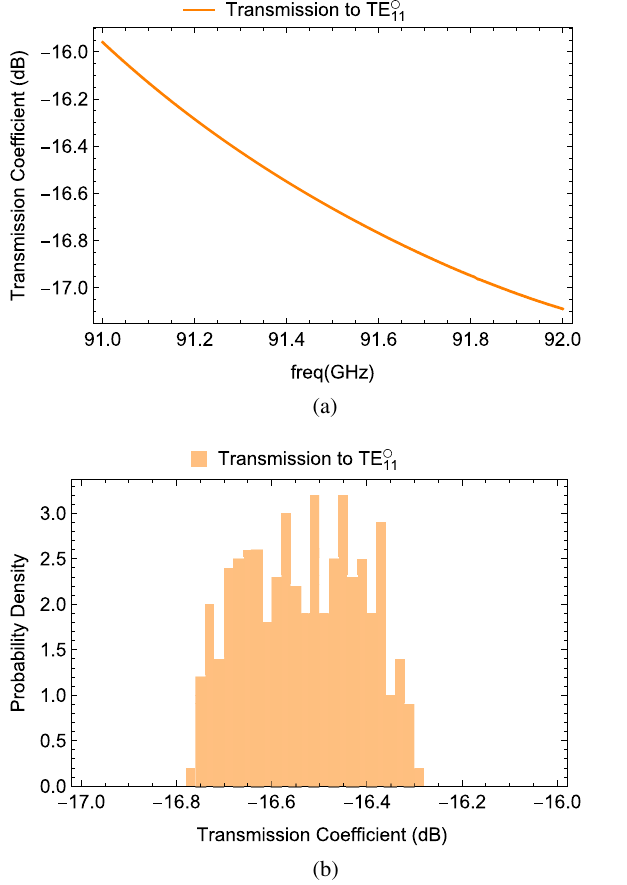
FIG. 9. Coupling end section transmission to the beam pipe. Note that only TE ○ 11 can propagate in the beam pipe of the coupling end section. (a) Transmission coefficient of the coupling end section vs frequency and (b) transmission coefficient of the coupling end section tolerances, obtained by varying 4 geomet- rical parameters uniformly ±5 μ m. FIG. 10. Reflecting end section transmission to the beam pipe. Note that both TE ○ 11 and TM ○ 11 can propagate in the beam pipe of the reflecting end section. (a) Transmission coefficient of the reflecting end section vs frequency and (b) transmission coef- ficient of the reflecting end section tolerances, obtained by varying 4 geometrical parameters uniformly ±5 μ